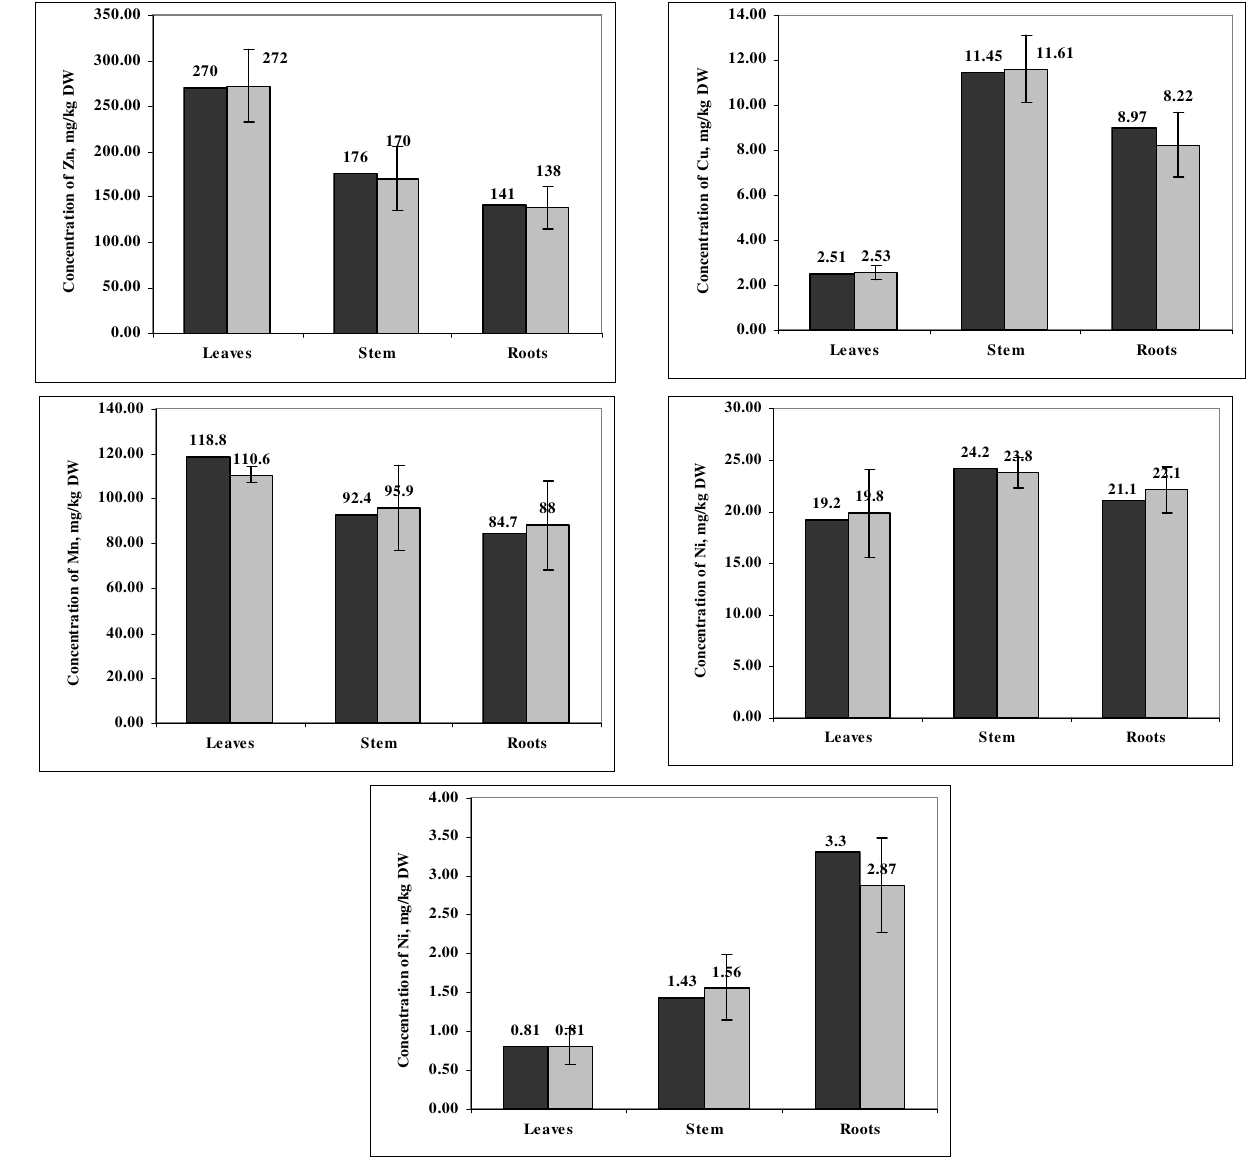
Fig 3. Concentration of TMs in three compartments of a leafy tree (birch and black alder): simulation results are in black, and experimental results – in grey (the bars denote ± SE, n = 4) Mean values of corrective coefficients were 2.0